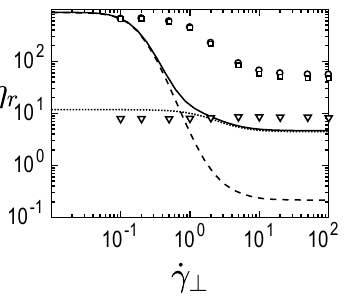
Figure 3. Reduced viscosity as a function of nondimensional transverse strain rate from the constitutive model of [3]. Full curve: total value; dashed curve, contact contribution; dotted curve, hydrodynamic contribution. Circles, squares and inverted triangles: the same quantities measured in particle-based simula- tions. See [3] for further